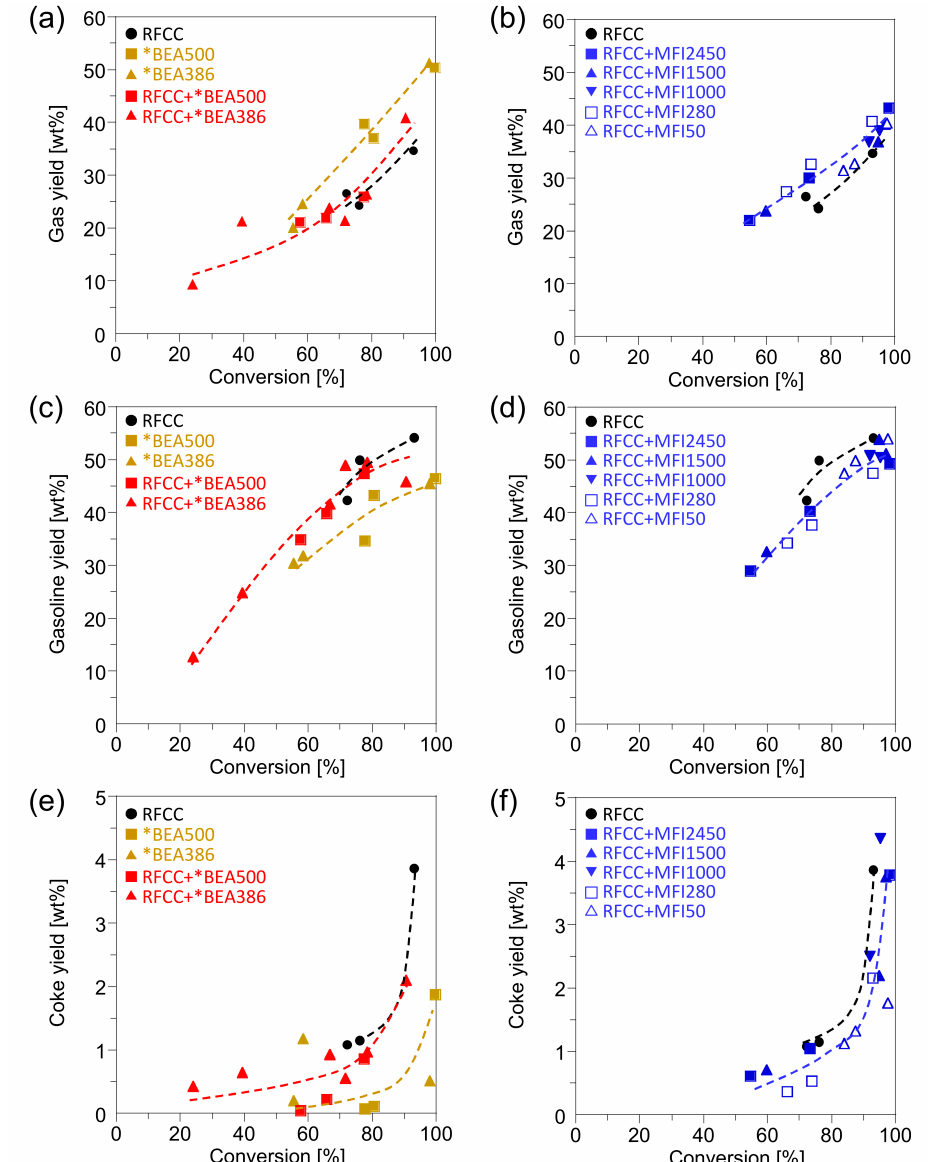
Figure 2. Reaction product yields of n -hexadecane cracking on the RFCC and the composite catalysts. ( a )( b ) Gas yield. ( c )( d ) Gasoline yield. ( e )( f ) Coke yield. ( a )( c )( e ) Reaction product on the *BEA catalyst and the composite catalyst with the *BEA zeolite. ( b )( d )( f ) Reaction product on the composite catalyst with the MFI